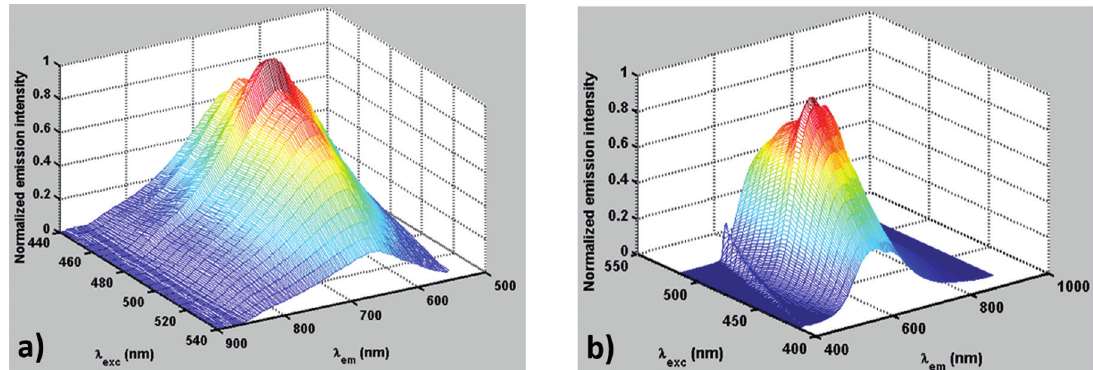
Figure 10: Emission spectra of (a) MPA-capped CdSe QDs and (b) GSH-capped CdSe QDs obtained at 30 min of synthesis, after excitation at various wavelengths.